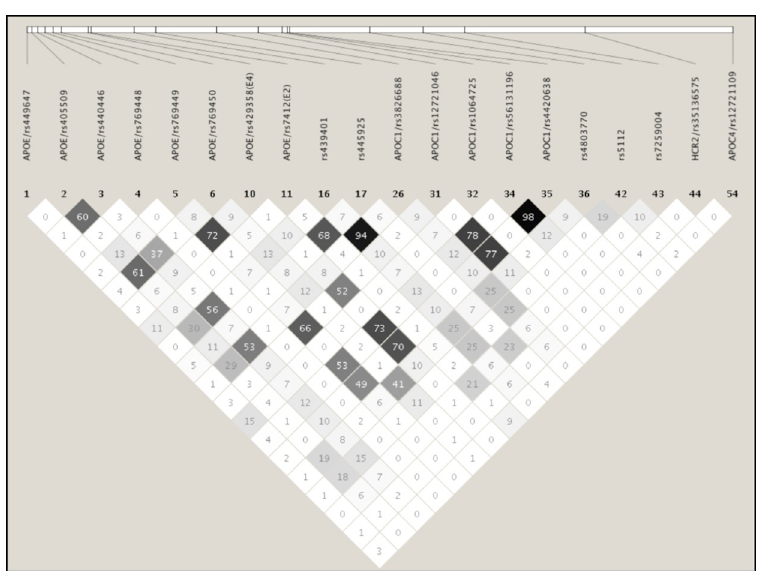
Fig 1. LD plot of the 20 common/uncommon variants (MAF > 1%) showing suggestive evidence of association with lipid traits in NHWs. The values in the cells are the pairwise degree of LD indicated by r 2 × 100. r 2 = 0 is shown as white, 0 < r 2 < 1 is shown in gray and r 2 = 1 is shown in